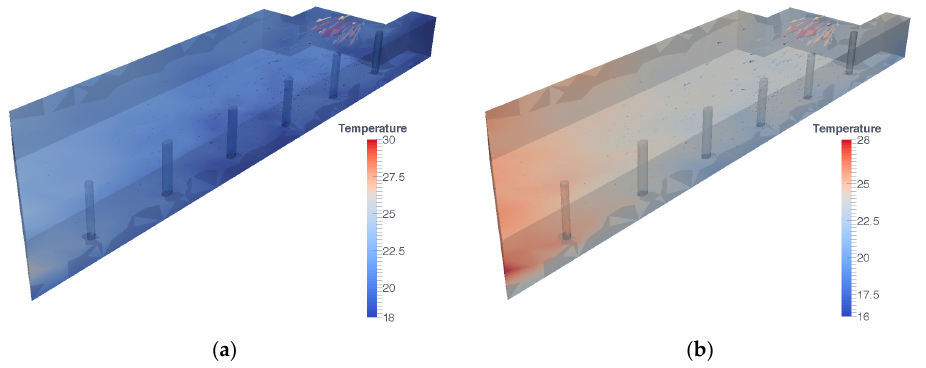
Figure 16. Case 2: Efficient energy proposal. 3D image of temperature distribution at 0:00 hours on the second day of calculation. ( a ) winter; ( b ) summer without free cooling.